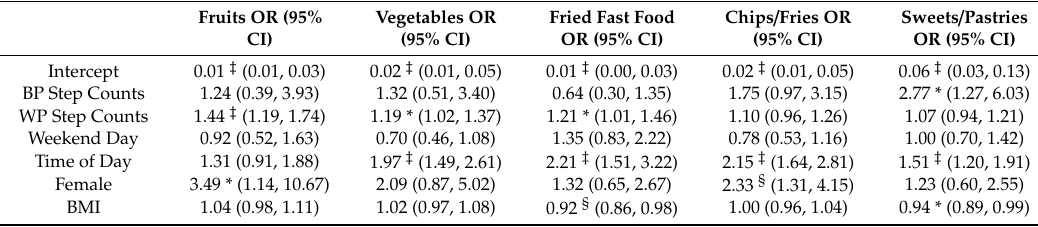
Table 2. Results from multilevel models predicting the odds of food consumption.